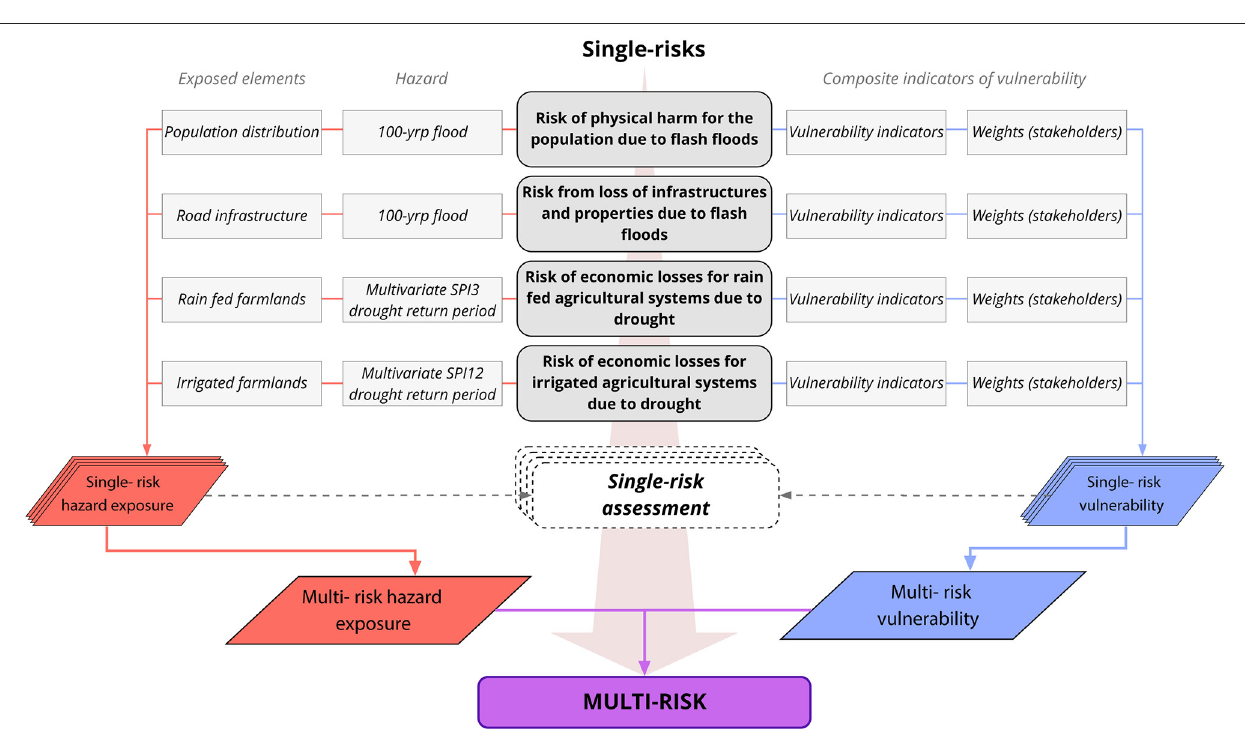
National Flood Protection Plan (PNI; Louodyi et al.,